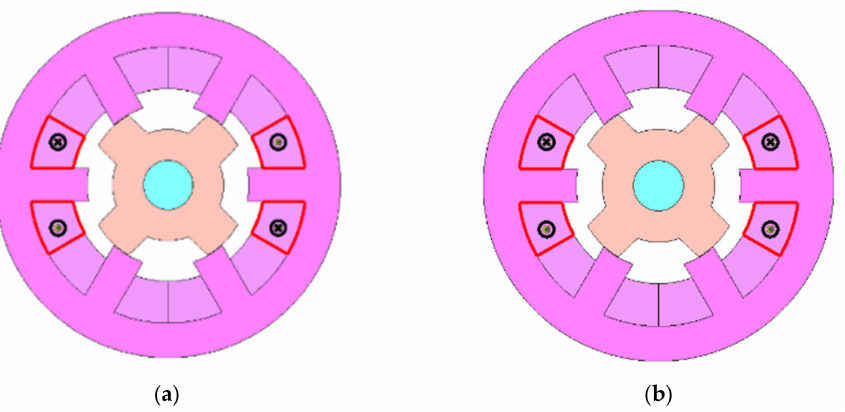
Figure 10. Winding configuration of the three-phase 6/4 pole SRM: ( a ) short-flux path; ( b ) long-flux